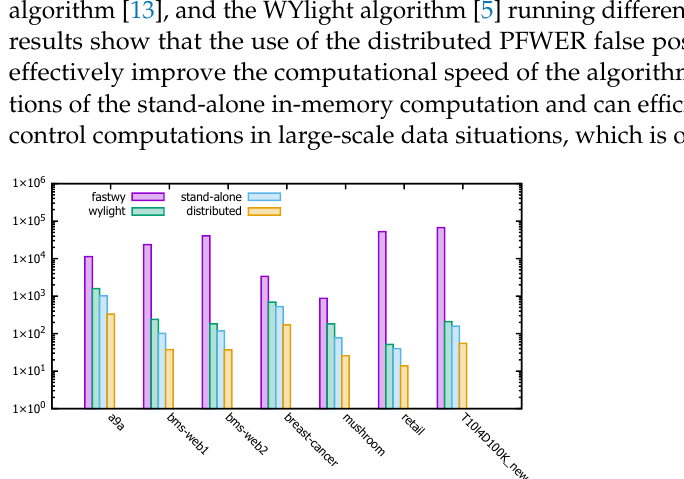
Figure 16. Runtime comparison of distributed PFWER control algorithms with existing